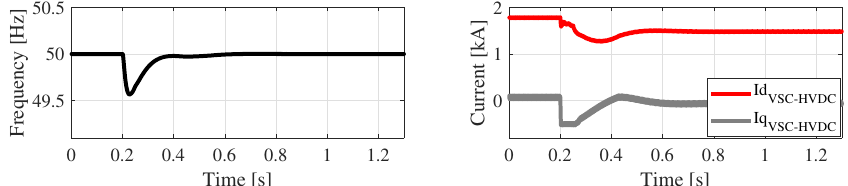
Figure 11. Offshore frequency ( left ) and currents ( right ) of VSC2 in the dq synchronous frame when the HVAC link